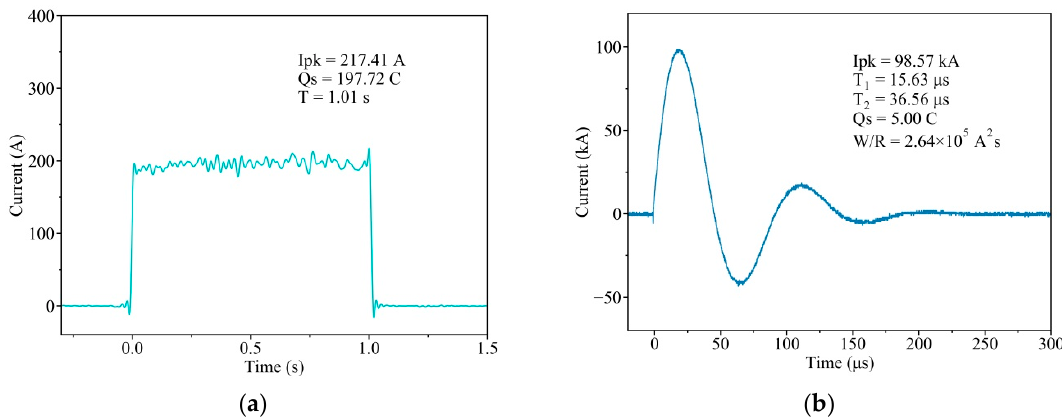
Figure 3. Lightning current waveforms used in the present study: ( a ) component C; ( b ) component D.